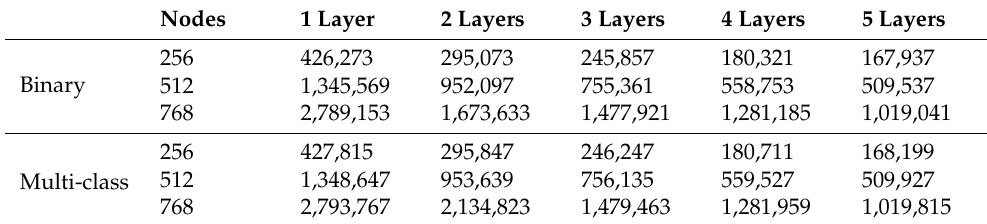
Table 18. The number of parameters of the CNN + LSTM model. Nodes